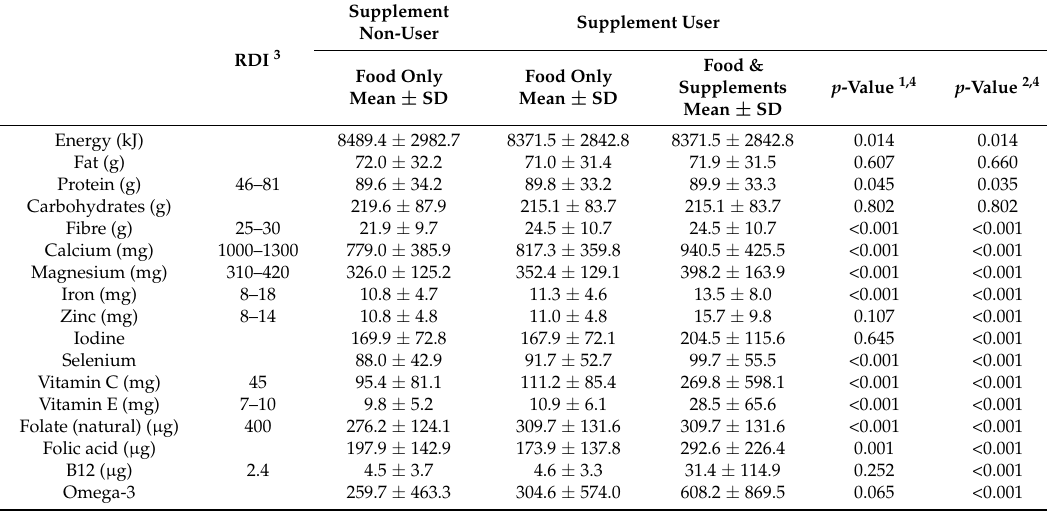
Table 5. Analyses for the association of nutrient intake between dietary supplement users and non-supplement users for adults from the Australian Health Survey ( n =